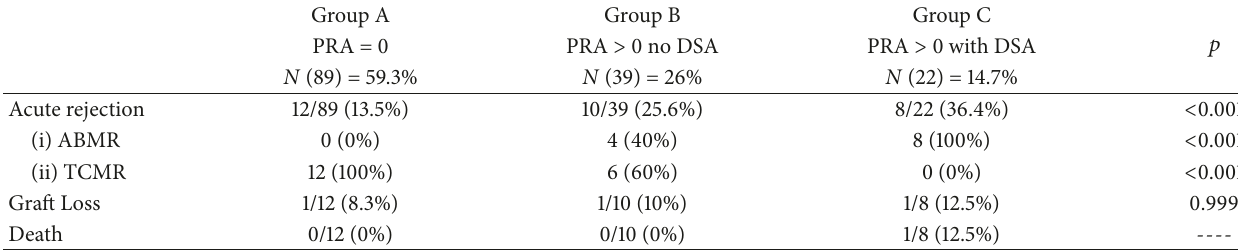
Table 2: Clinical outcomes according to pretransplant